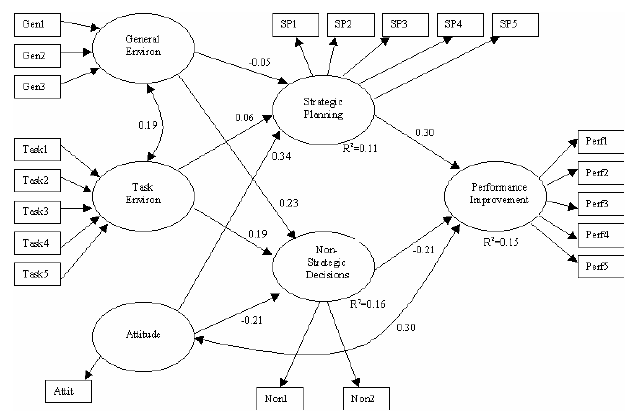
Figure 2: PLS results for structural model